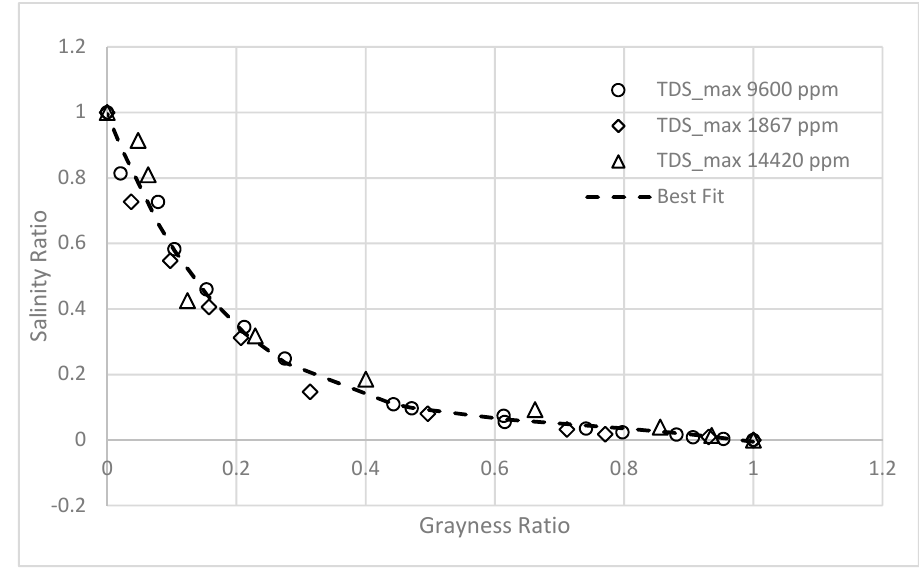
Figure 2. Gray Intensity-to-Salinity Calibration Curve.